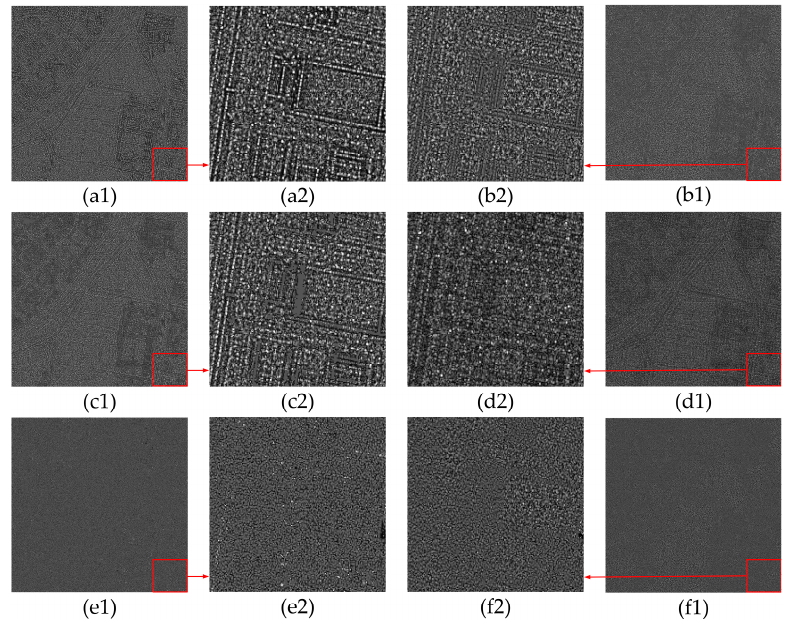
Figure 7. Ratio images by noisy TerraSAR-X SAR image and the ( a1 ) SRAD, ( b1 ) DPAD, ( c1 ) EnLee, ( d1 ) PPB, ( e1 ) SAR-BM3-D, and ( f1 ) FANS filtered images. ( a2 – f2 ) are the enlarged images of the red rectangle from ( a1 – f1